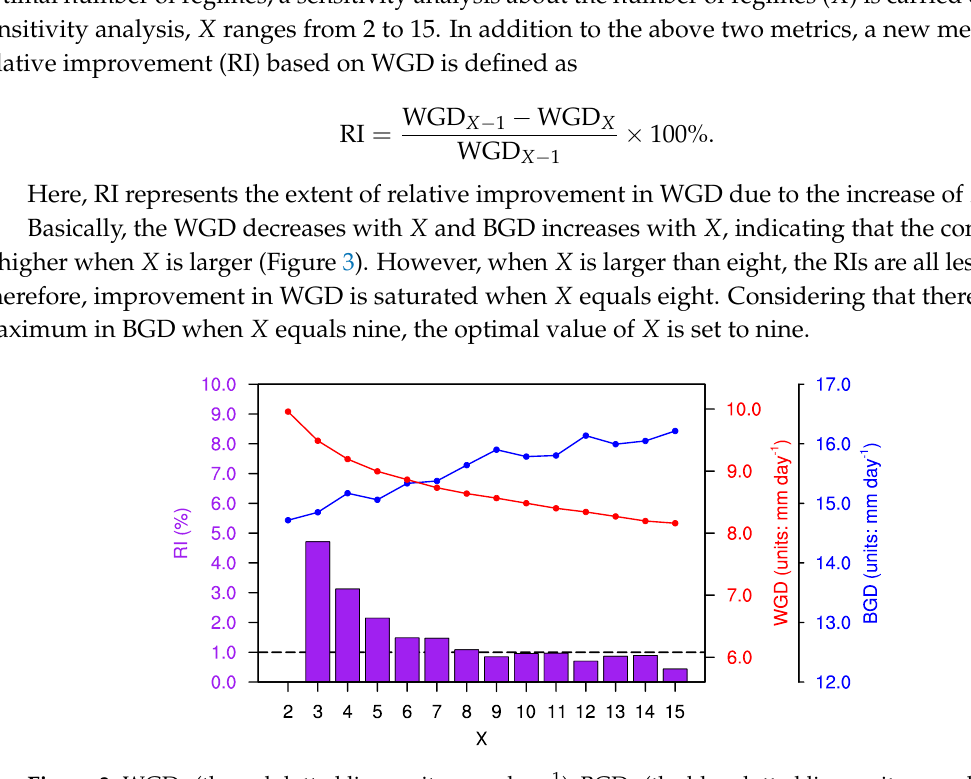
Figure 3. WGDs (the red dotted line; units: mmday − 1 ), BGDs (the blue dotted line; units: mmday − 1 ) and RIs (the purple bars; units:%) when the number of regimes X is varied. The black dashed line denotes that RI equals